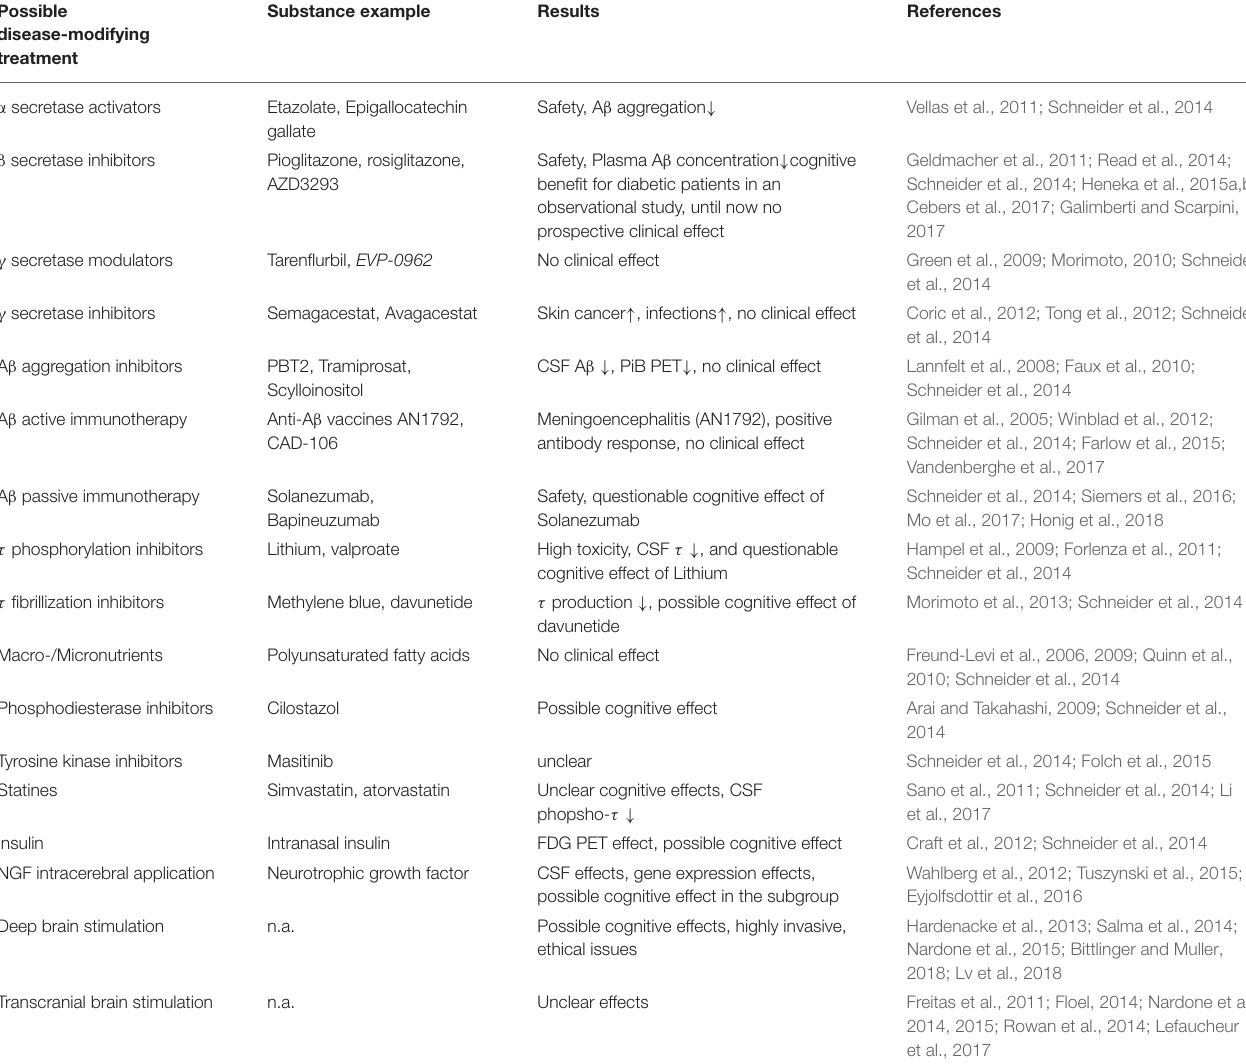
TABLE 1 | Ongoing developments for AD treatment and therapies. Possible